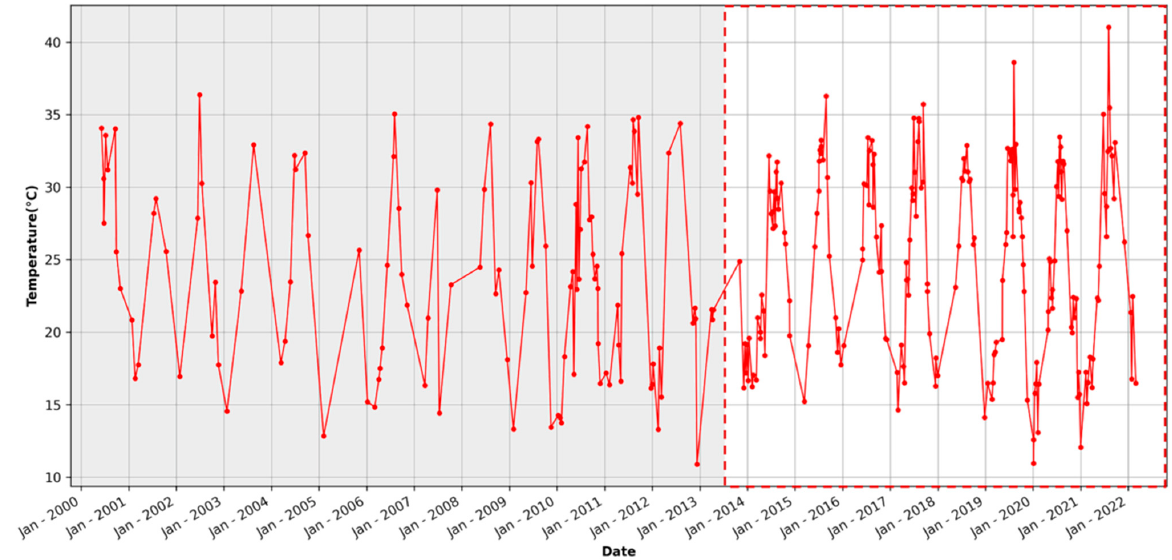
Figure 9. Cumulative (ASTER+TIRS) LST related to the PPI pixels (red line). For the time period ranging from January 2020 up to January 2022, an increase in temperature value is evident. In the red dotted box are plotted both ASTER and TIRS. Before 2014 (gray box) only ASTER data were available.